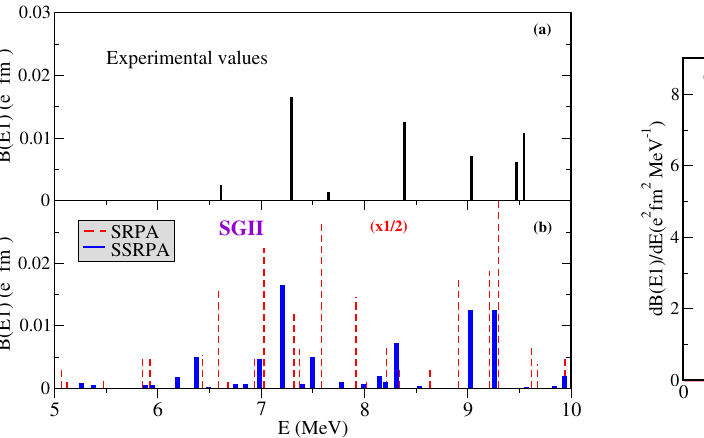
Figure 1. Low-lying dipole strength in 48 Ca : (a) Experimental B ( E 1) values [18]; (b) Theoretical predictions for the transition probabilities B ( E 1) calculated with the standard SRPA (dashed red bars; the values have been divided by 2) and with the SSRPA (blue thick bars).